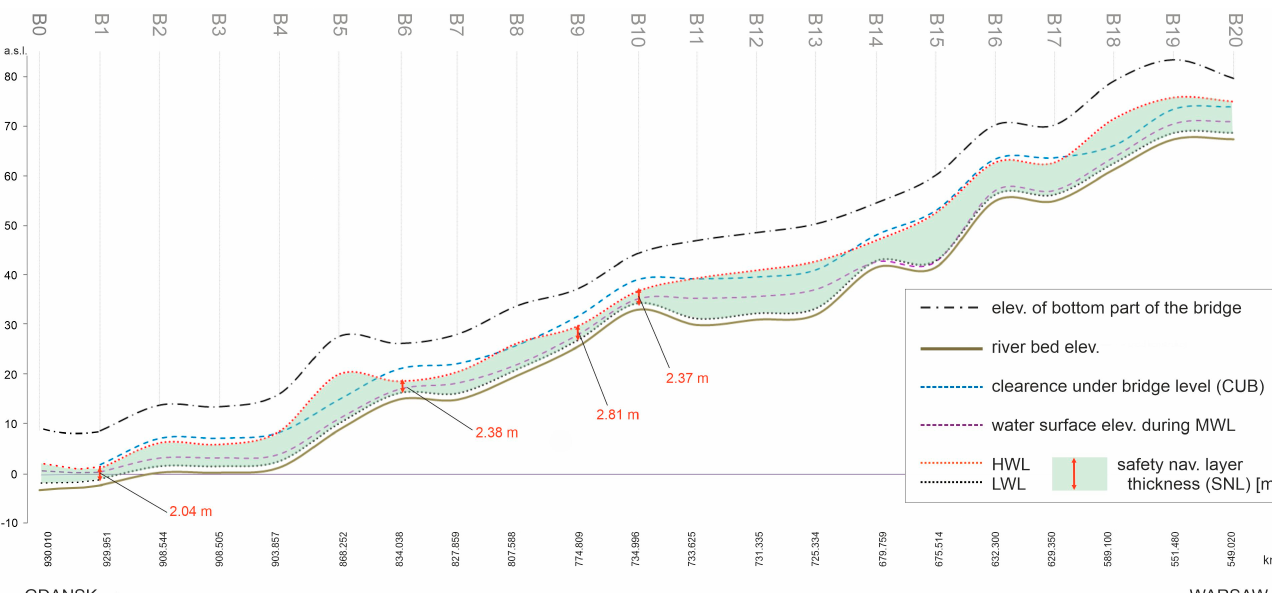
Figure 4. The differentiation of the thickness of the safe navigation layer (SNL) of Vistula’s water- way in terms of bridge structures—limitations and fluctuations of water stages in the longitudinal profile. Calculated high (HWL) and low (LWL) water level values were presented in Table 4; the other used values were presented in Table 2.